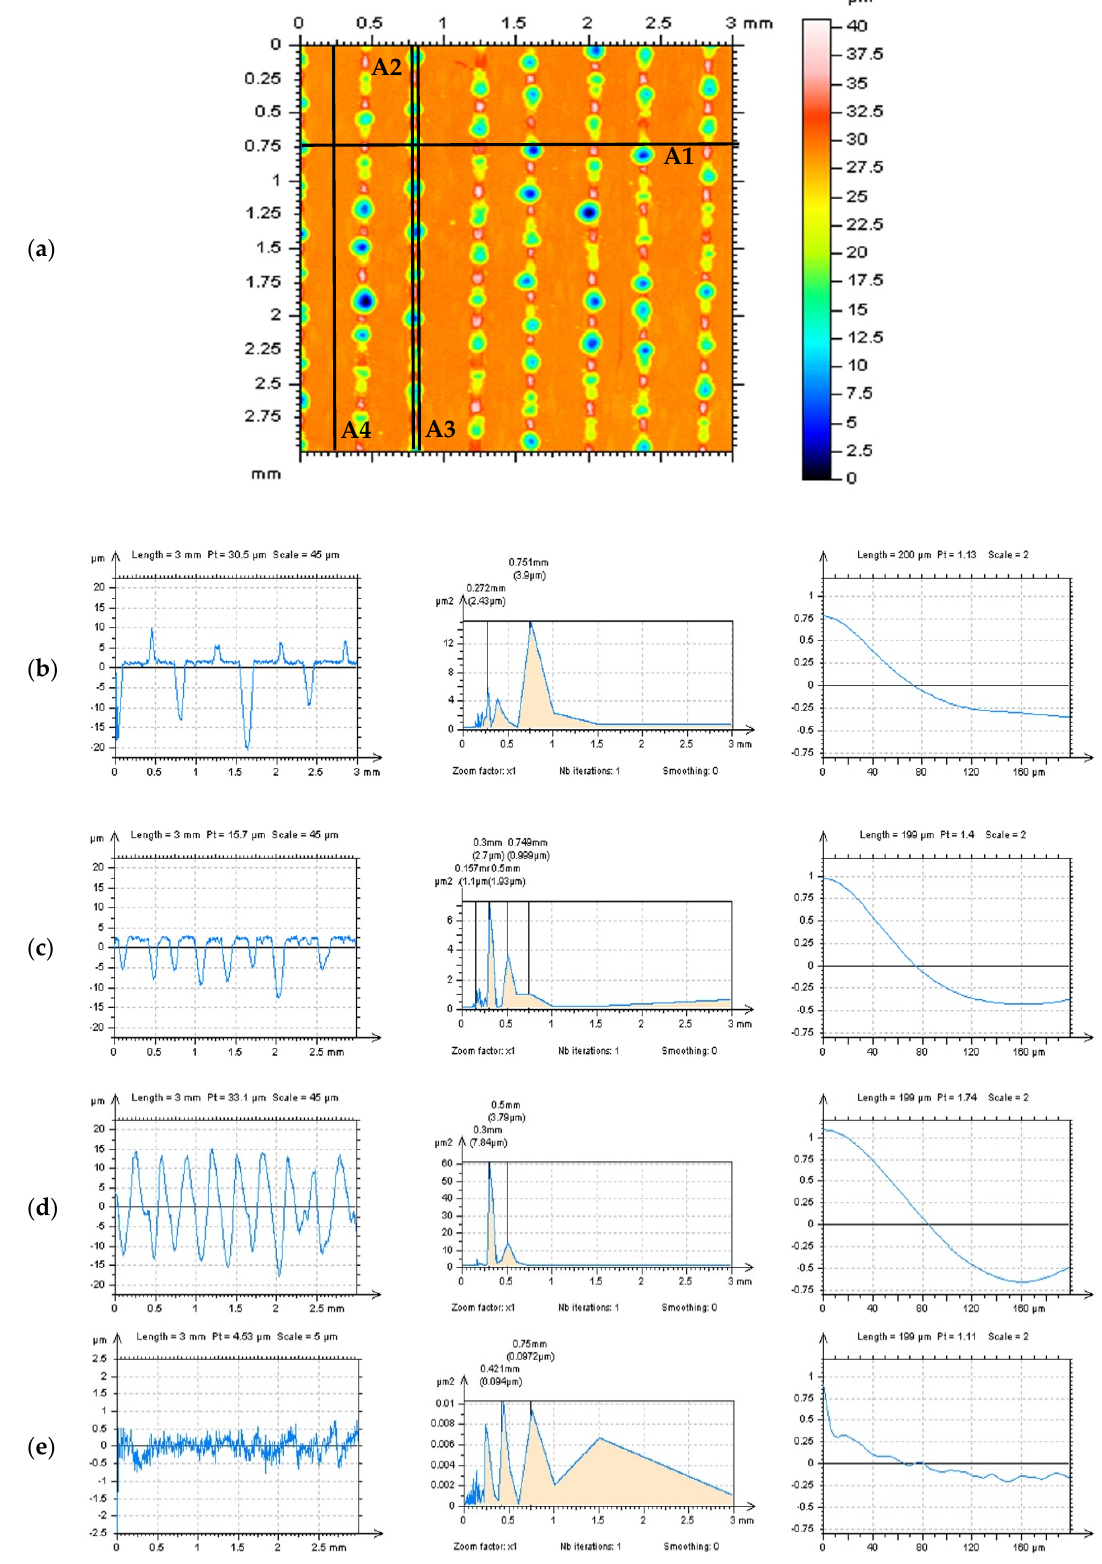
Figure 9. Methods of detection of the high-frequency errors by the analysis of the profiles, their PSDs and ACFs, corre- spondingly, extracted from laser-textured surface topography, received by extraction in different directions and areas ( a ) of analyzed detail, as follows: A1 ( b ), A2 ( c ), A3 ( d ), and A4 ( e )